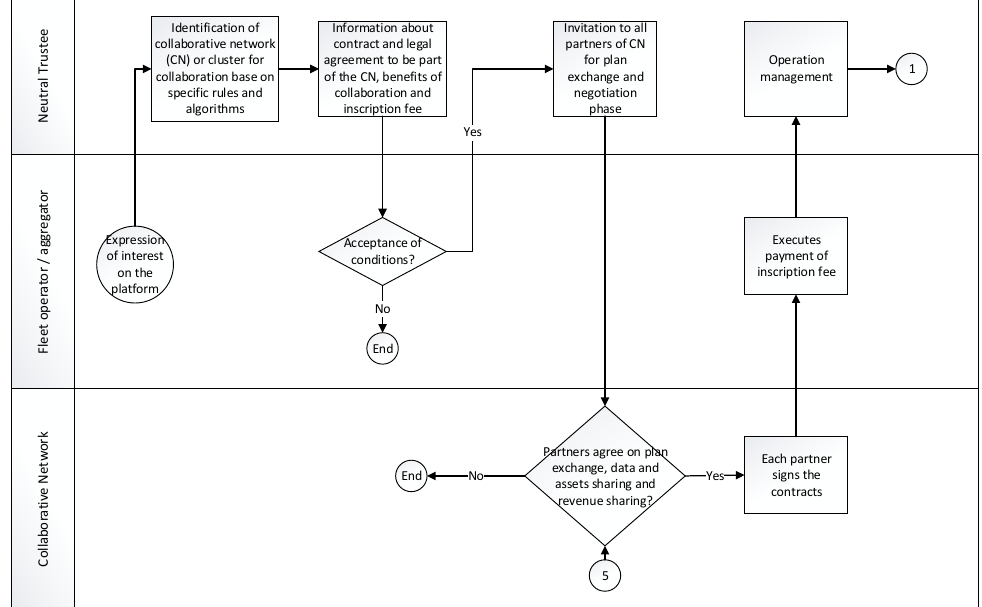
Figure 11. Workflow for proposed FSL business model—Collaboration initiation, Plan exchange, Negotiation and Revenue sharing.